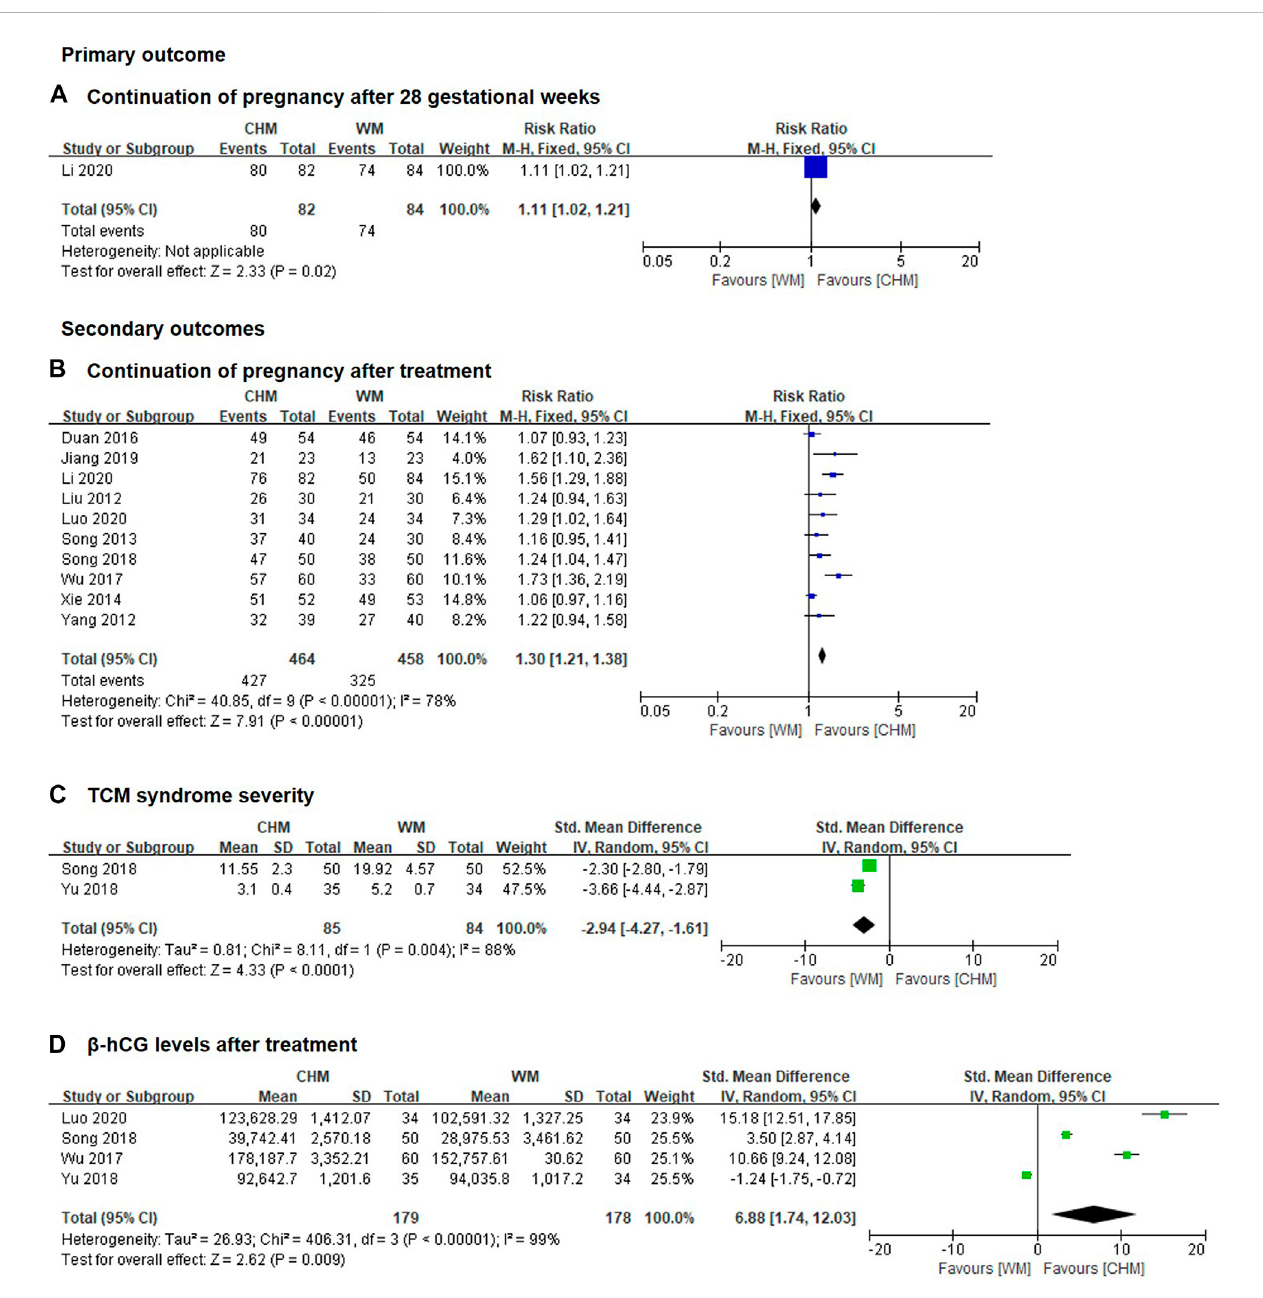
FIGURE 2 Forest plot of CHM alone group vs. WM alone group (A) continuation of pregnancy after 28 gestational weeks; (B) continuation of pregnancy after treatment; (C) TCM syndrome severity; (D) β -hcG levels after treatment.